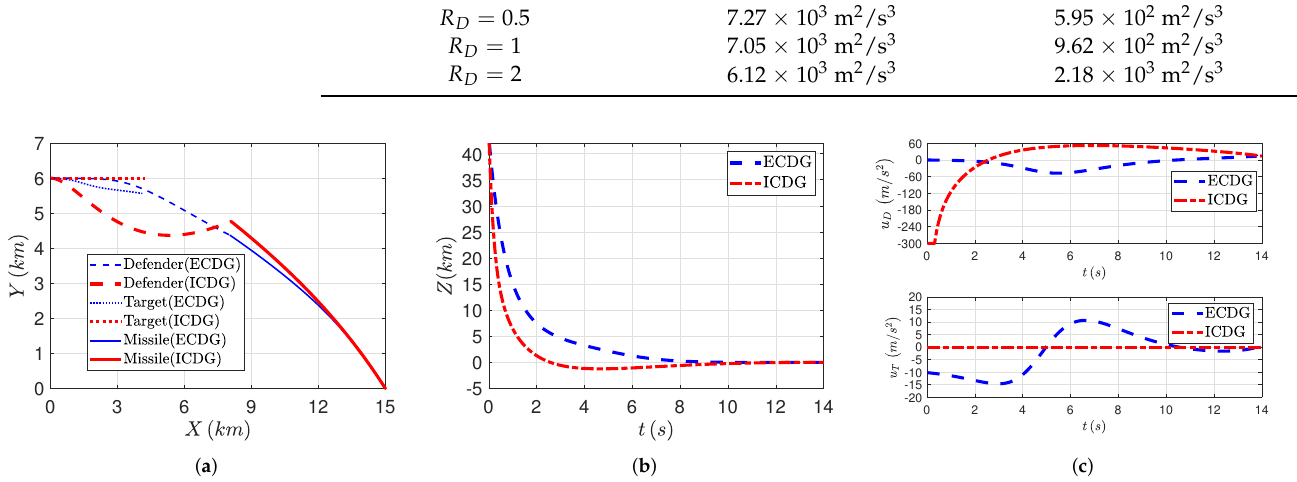
Figure 2. The simulation results of the proposed guidance law. ( a ) Trajectory, ( b ) Zero-effort error distance, ( c ) Guidance